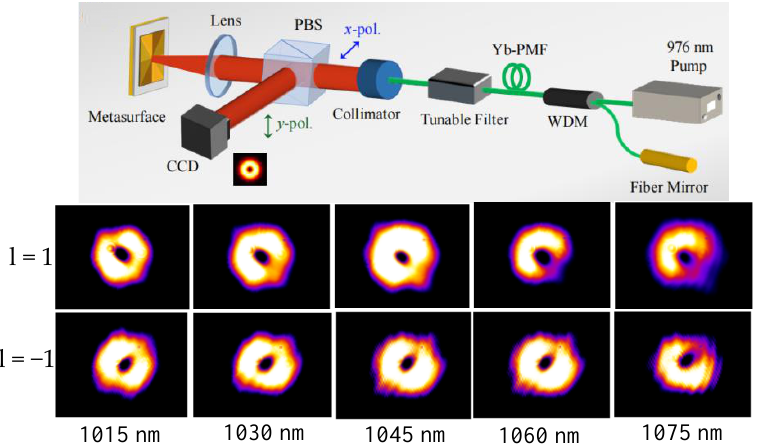
Figure 22. Schematic of the structured light fibre laser and intensity profiles of structured light beams with l = ±1, the wavelength could vary between 1015 nm and 1075 nm (Adapted from an open-access source Ref. [128]).